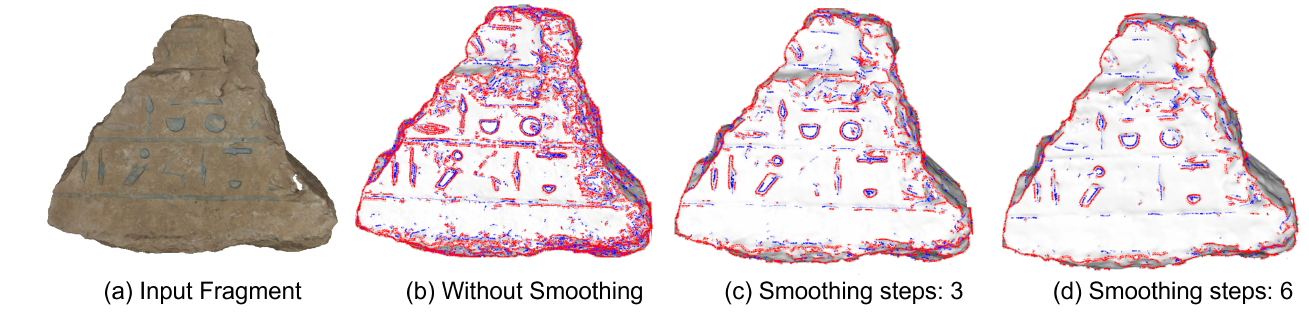
Figure 5. Ridge–valley lines extraction of a decorated fragment smoothed with 0, 3, and 6 steps. Ridges and valley surfaces are marked in red and blue lines, respectively.